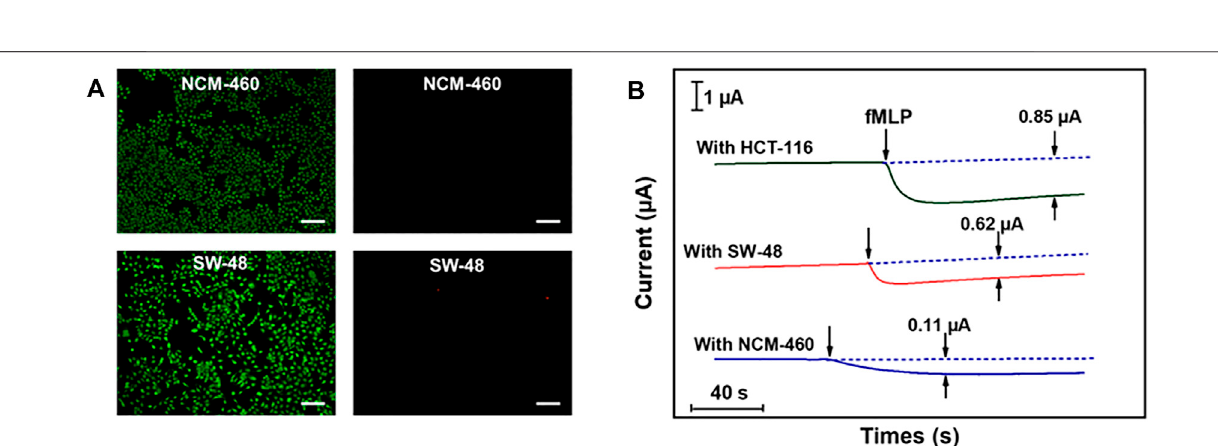
FIGURE7|(A) Liveanddead body fl uorescenceimages ofSW-48andNCM-460cells, detected byCalcein-AM/PI, withCalcein-AMstainingsurvivingcellsgreen and PI staining dead cells red. Scale bar, 100 μ m. (B) Amperometric current responses of Cu 2 (OH) 3 NO 3 @ZnO/AGF to the addition of 10 μ M fMLP in test solution containing 5.0 × 10 6 NCM-460, SW-48, and HCT-116